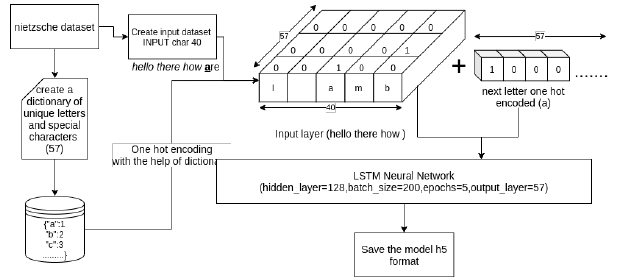
Figure 1. Our Proposed Work flow